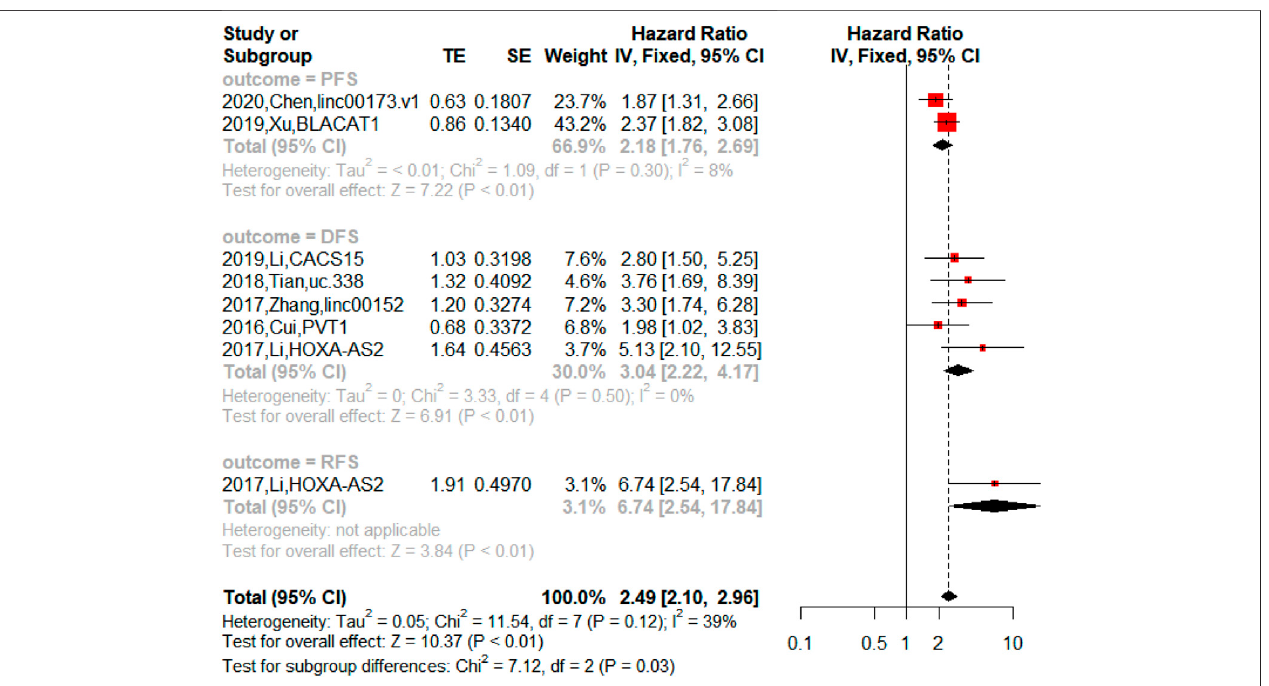
FIGURE 5 | Forest plots of the association between upregulated lncRNAs and progression-free survival (PFS), disease-free survival (DFS), and recurrence-free survival (RFS) in NSCLC.